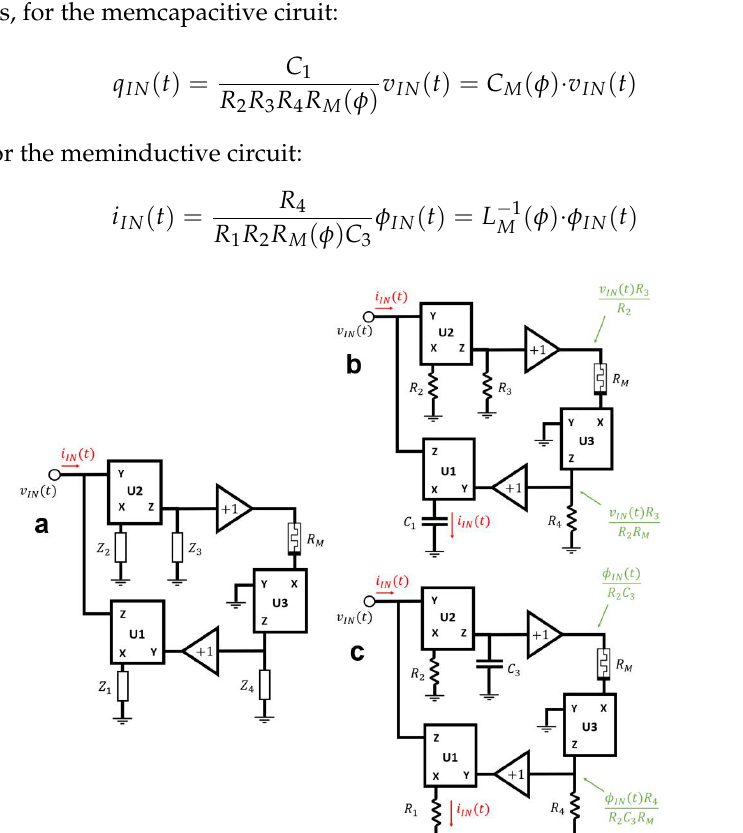
Figure 18. ( a ) Universal circuit for the emulation of grounded mem-elements proposed by Yu et al. [61]. ( b ) Mutator for the emulation of memcapacitors, ( c ) mutator for the emulation of meminductors.